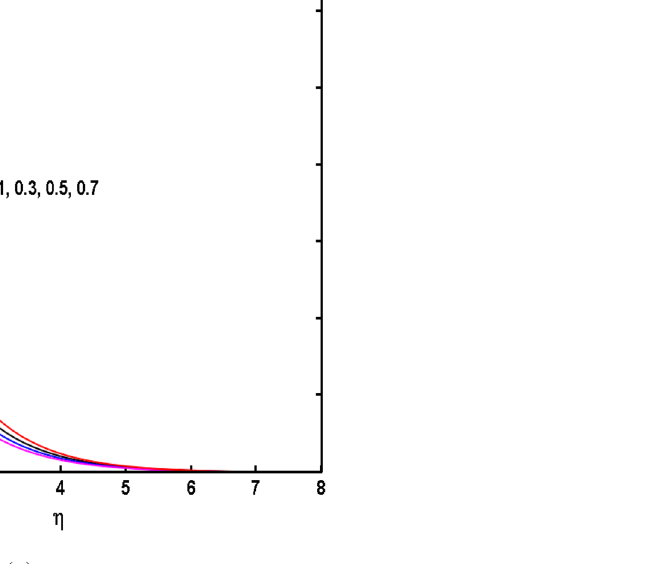
Figure 3. Variations of K to f ′ (η)